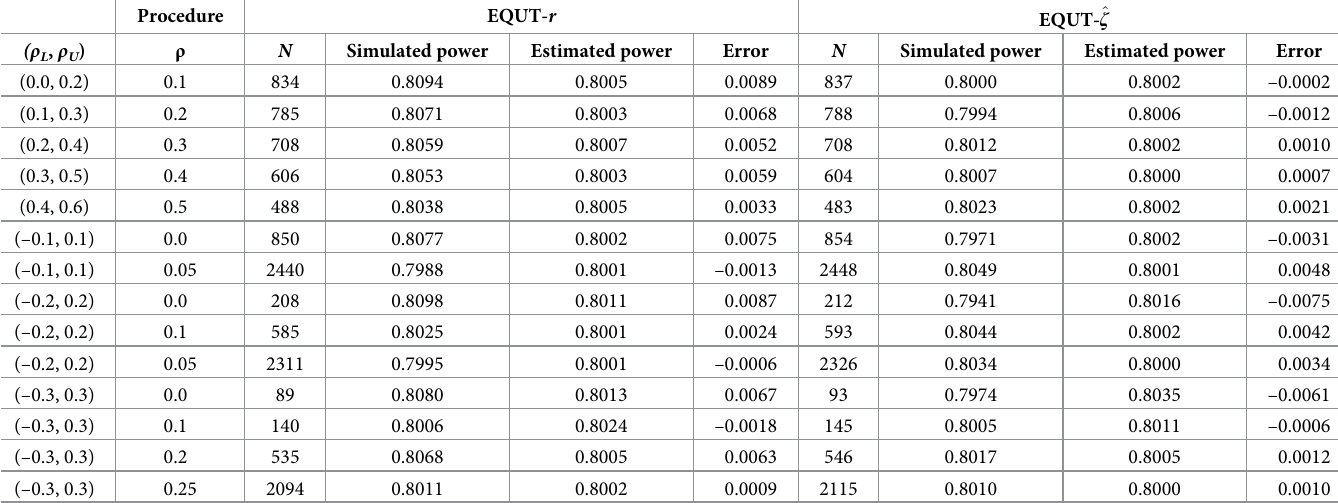
Table 5. Sample sizes, computed power, and simulated errors of the suggested equivalence tests for nominal power 0.80 and α = 0.05.